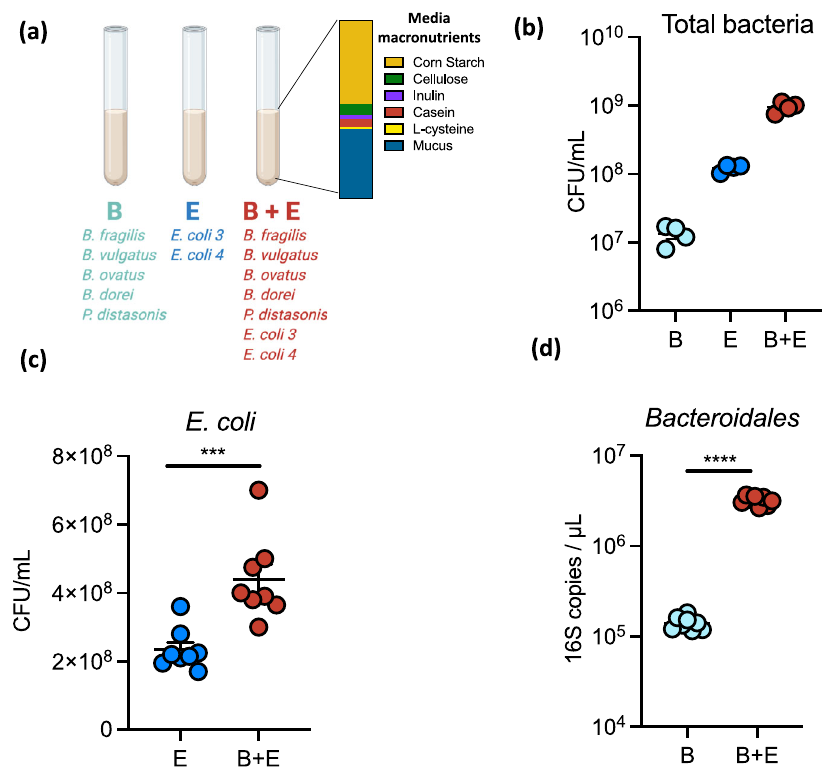
Fig. 1 Synergistic growth of Bacteroidales and Enterobacteriaceae in co-culture. a Schematic of the experimental set-up. After a 24 h culture, bacterial endpoint growth was determined for ( b ) the total community ( n = 4), c E. coli ( n = 8), and d Bacteroidales ( n = 8). Mean + / − SEM are displayed. Signi fi cance was determined by two-sided t test. *** P < 0.001; **** P < 0.0001. c , d B Bacteroidetes mix, E E. coli mix, CFU colony-forming units. Source data are provided as a Source Data fi le. Exact P values and test statistics are reported in Supplementary Table